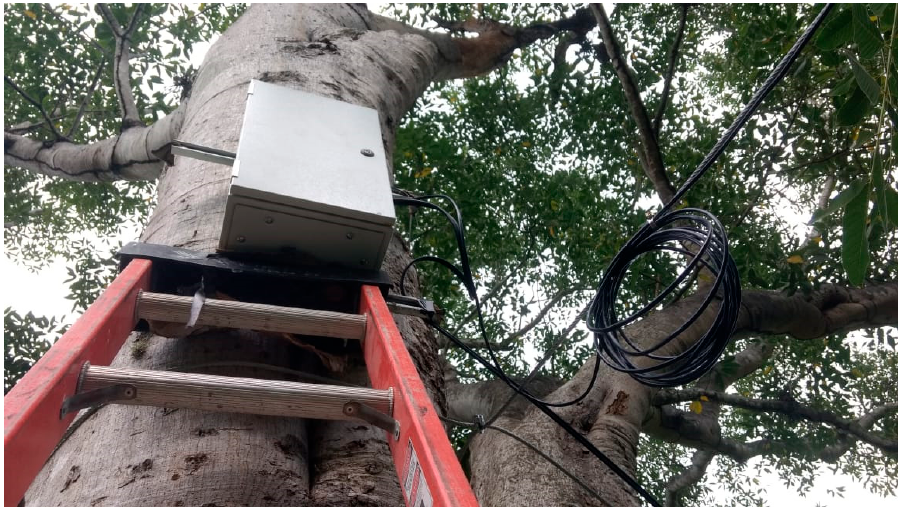
Figure 17. Deployed fixed node.